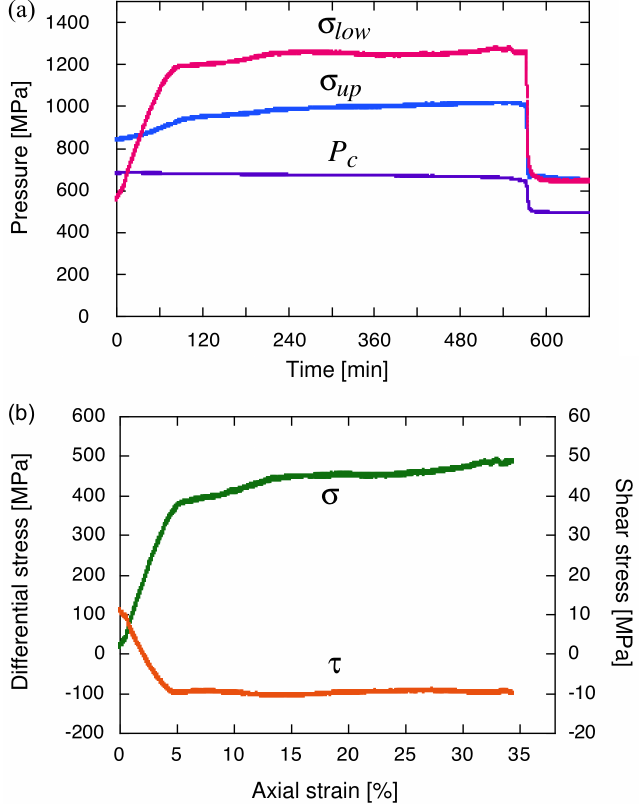
Figure 7. ( a ) Mechanical data obtained in the constant strain rate test of agate (W02) carried out at 800 ◦ C. ( b ) Stress–strain curve (green) and change in shear stress acting on the cylinder core (red). Abbreviations are the same as those in Figure